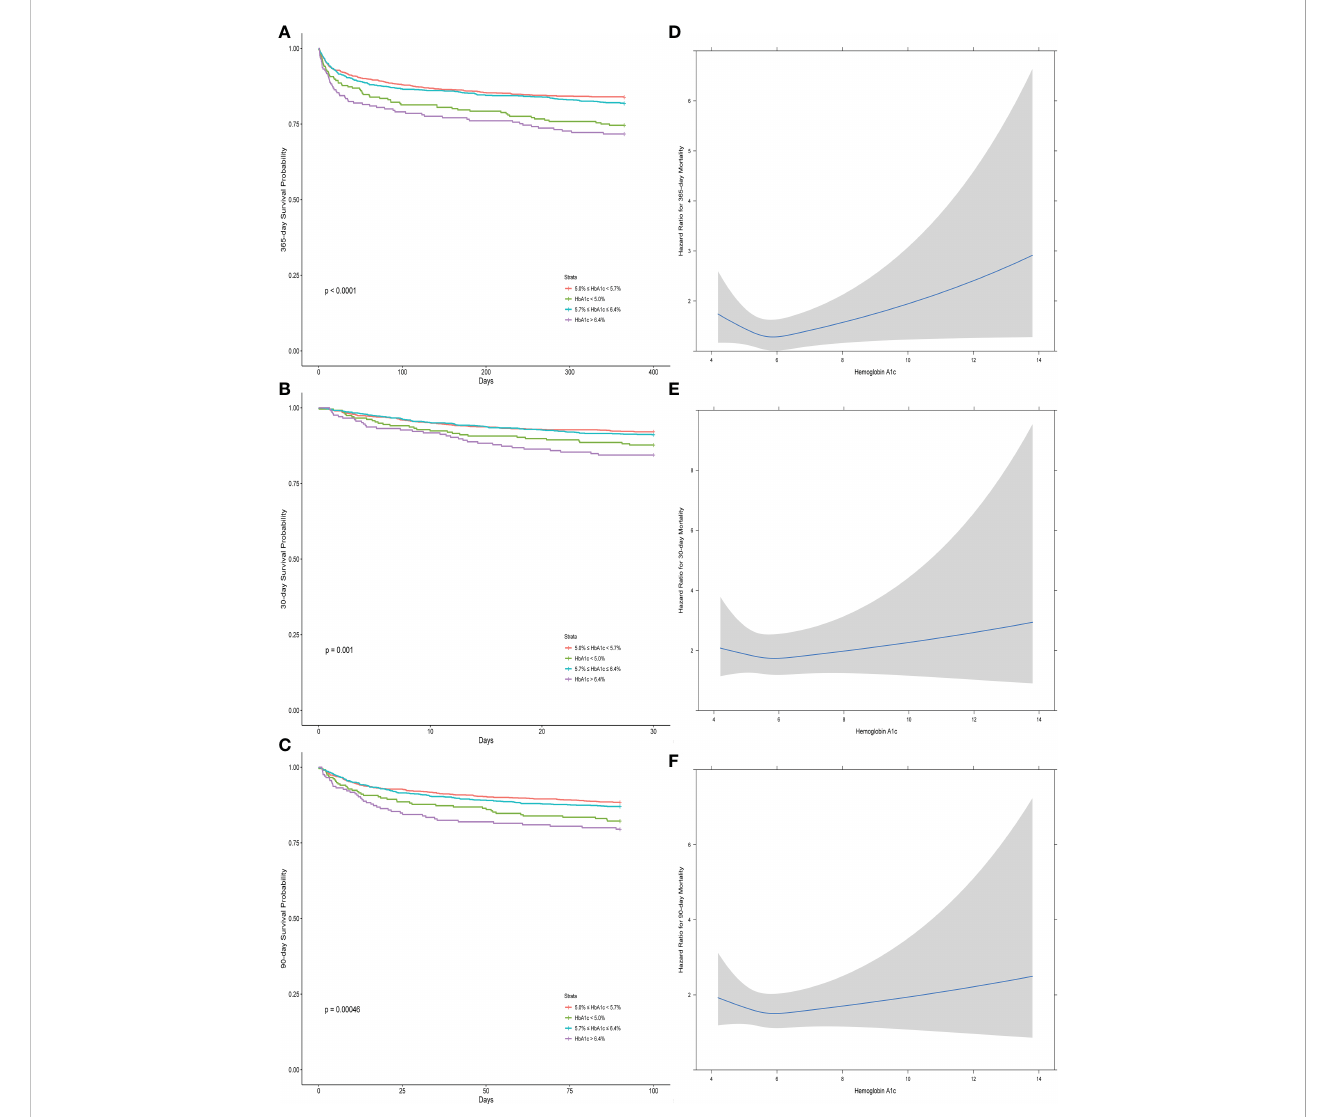
FIGURE 2 The Kaplan – Meier curves (A – C) and the restricted cubic splines (D – F) between the hemoglobin A1c and different outcomes (30-day, 90-day, and 1-year mortality).